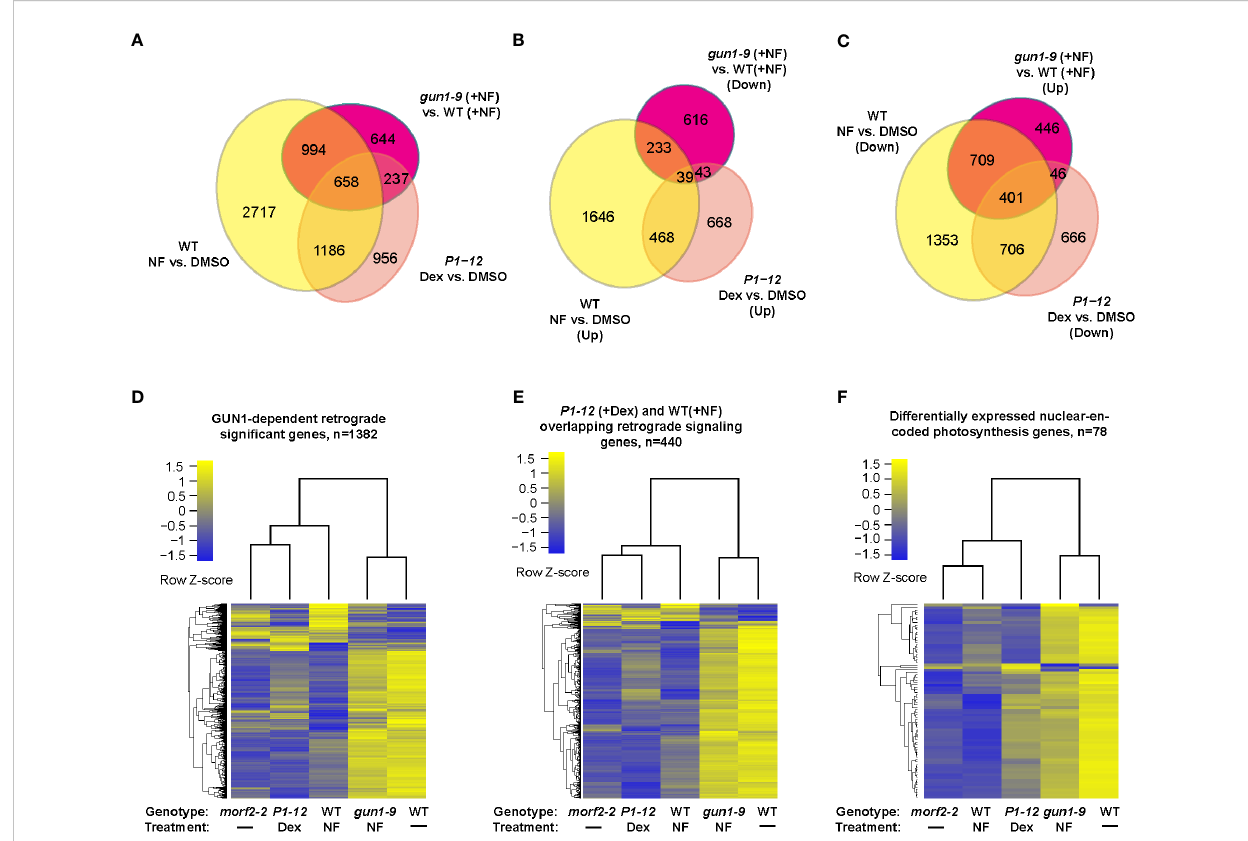
FIGURE 4 Cross experimental comparison demonstrates MORF2 as an effector of RS in chloroplasts. (A) Overlap of SDEGs resulting from MORF2 reduction in P1-12 (+0.25 m M Dex) with known SDEGs involved in RS either in WT (Col6-3; +NF) or in gun1-9 (+NF). The Venn diagram shows the overlap of SDEGs identi fi ed in P1-12 (+0.25 m M Dex), WT (+NF), and gun1-9 (+NF) compared to the corresponding controls indicated. A gene was retained for comparison if its CPM was above 0.5 in at least 11 samples from two replicates each of P1-12 (+DMSO), P1-12 (+0.25 m M), WT (+DMSO), WT (+NF), gun1-9 (+NF), and morf2-2 . (B, C) Identifying the group of known GUN1-dependent RS genes and its overlap with up and downregulated SDEGs in P1-12 (+0.25 m M Dex). Shown are two Venn diagrams indicating the overlap of up or downregulated SDEGs from three different transcriptome